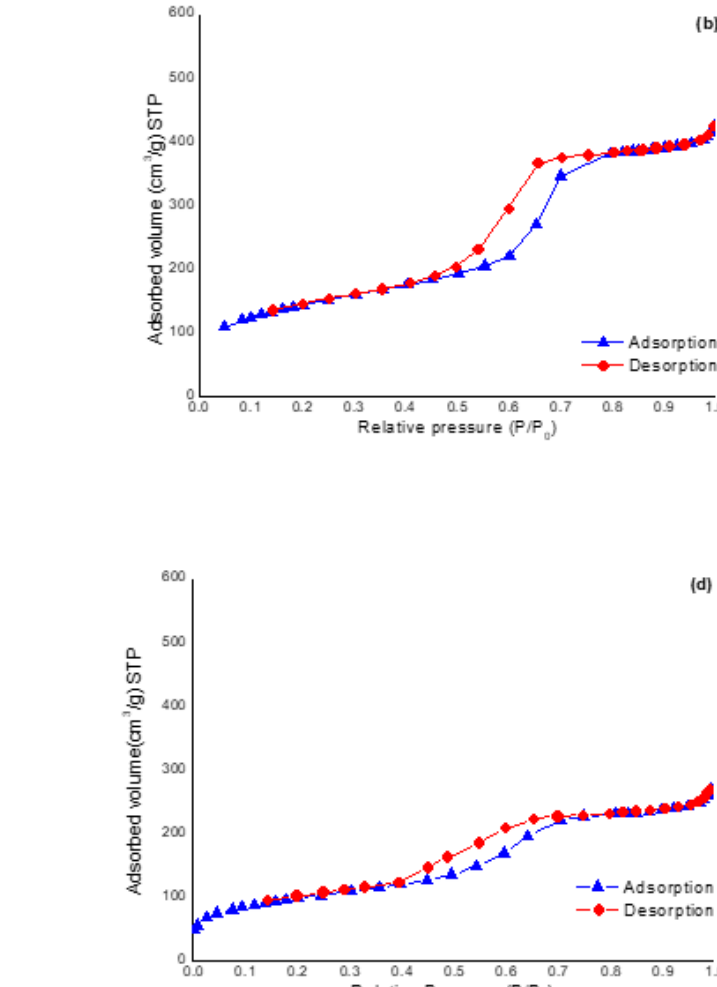
Figure 2. N 2 adsorption-desorption isotherms of the following materials: ( a ) SBA-15, ( b ) L-SBA-15-SO 3 − , ( c ) M-SBA-15-SO 3 − and ( d ) H-SBA-15-SO 3 − .